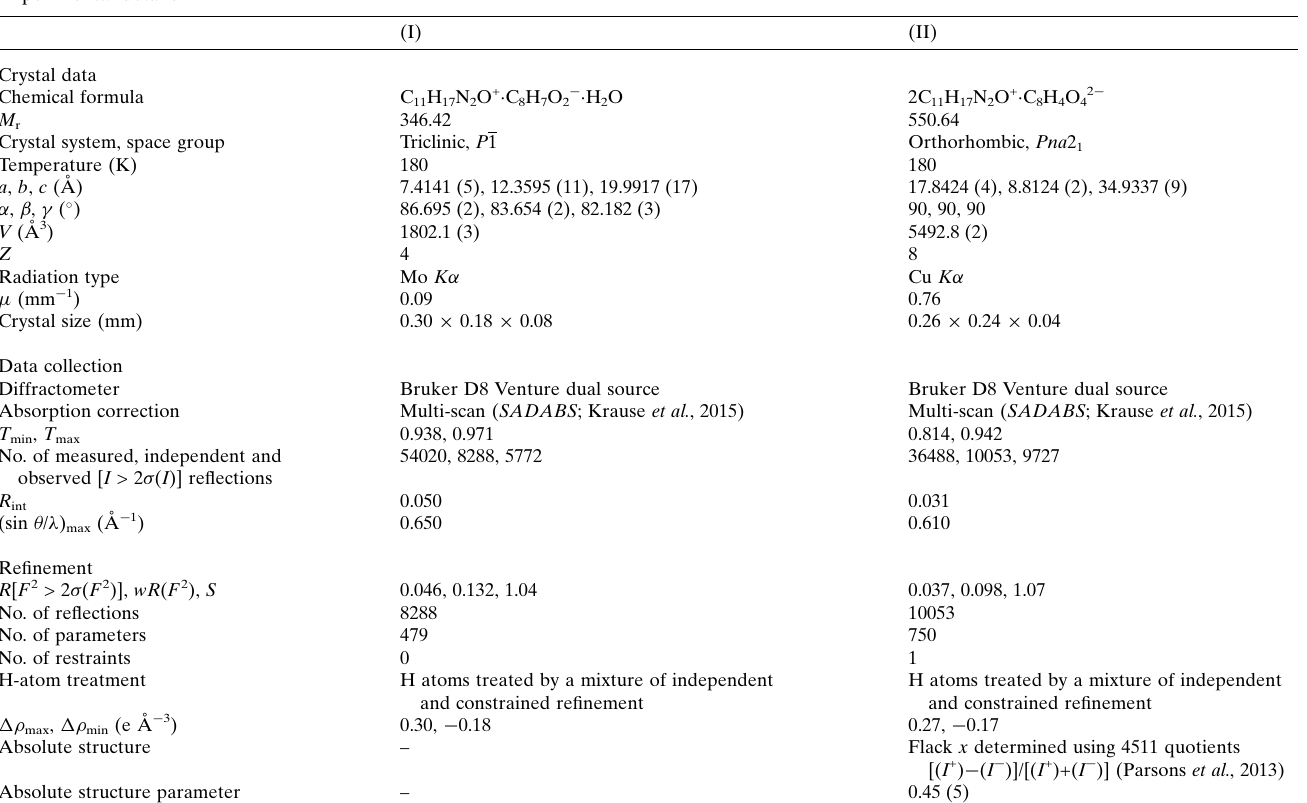
Table 3 Experimental details.